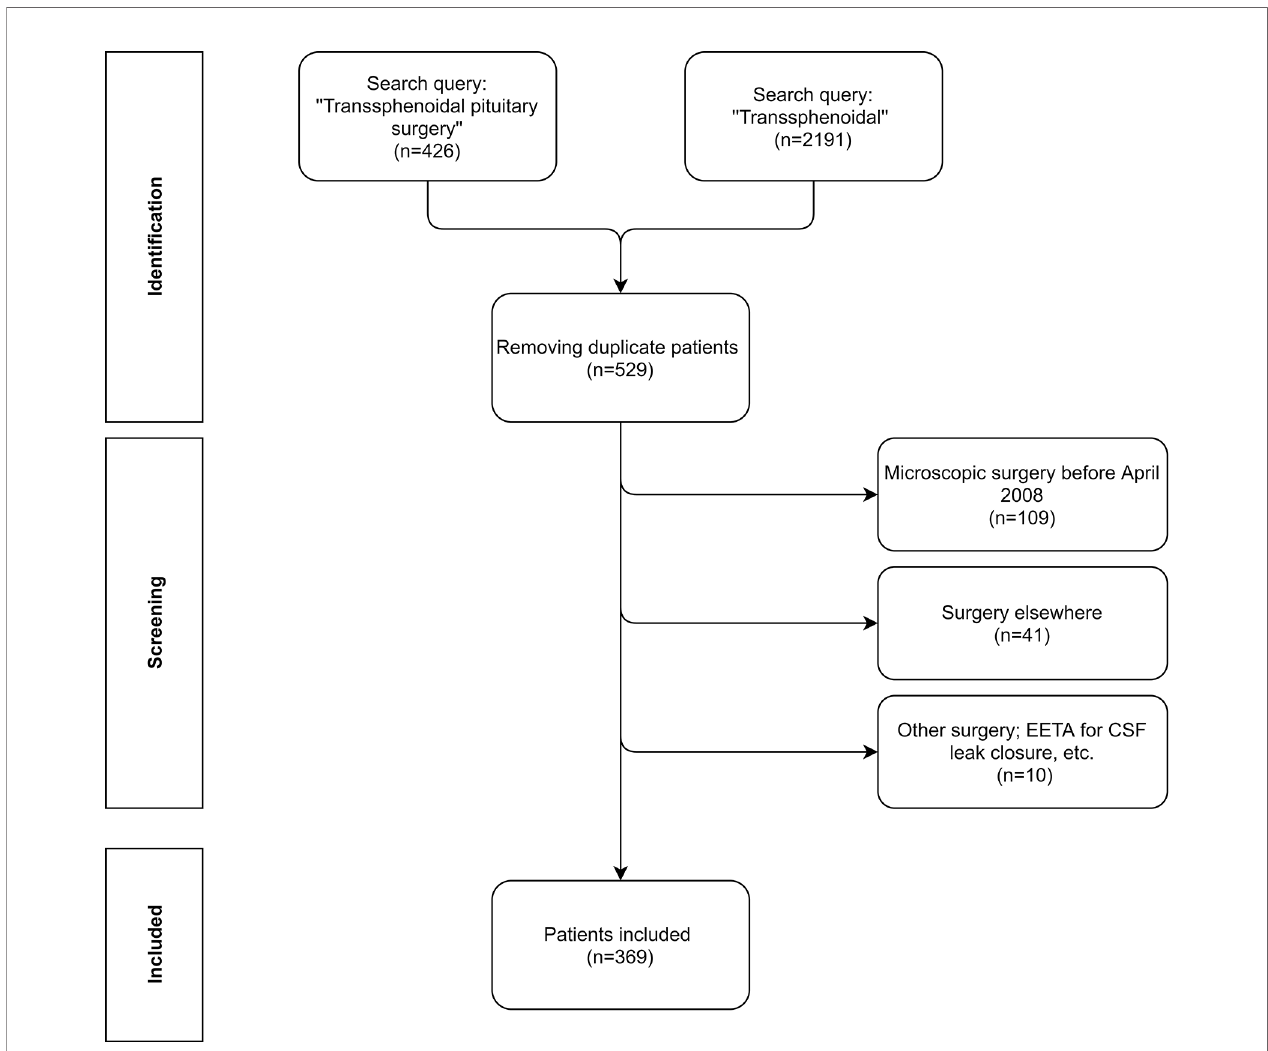
FIGURE 1 | Flow diagram of the patient inclusion process. The patients were initially identi fi ed using two search queries: ‘‘ Transsphenoidal pituitary surgery ’’ ‘‘ Transsphenoidal ’’ in 2 databases; 1 was the billing fi le, the other the medical records. Afterwards, all of the unique patients were screened for the inclusion criteria. Note that at our hospital we do not have a separate code for CSF leak closure. Finally 369 unique patients were included in this